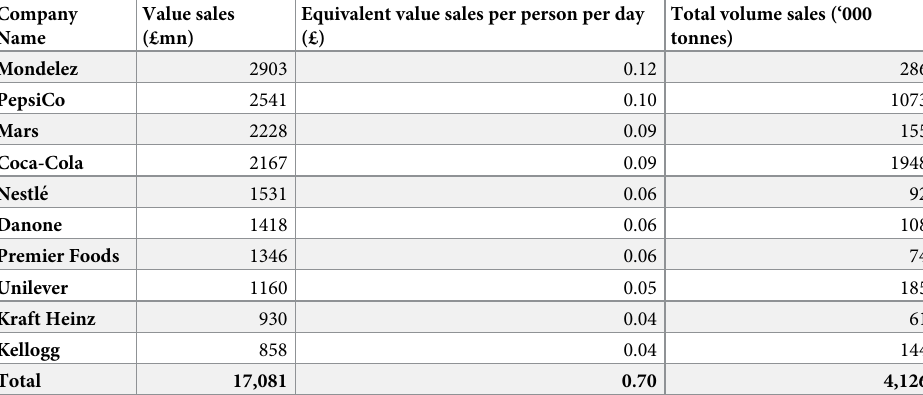
Table 1. Number of products, brands and total volume sales by company,